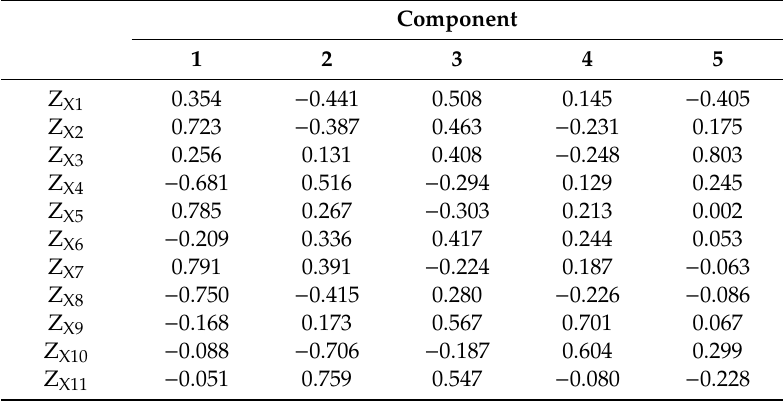
Table 3. Component matrix of principal